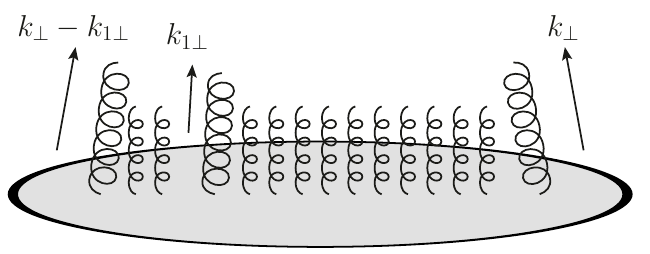
Figure 7 . Genuine saturation: for dense targets where gluon occupancy is large, the probability to extract more gluons is enhanced, hence an expected enhancement of genuine twist